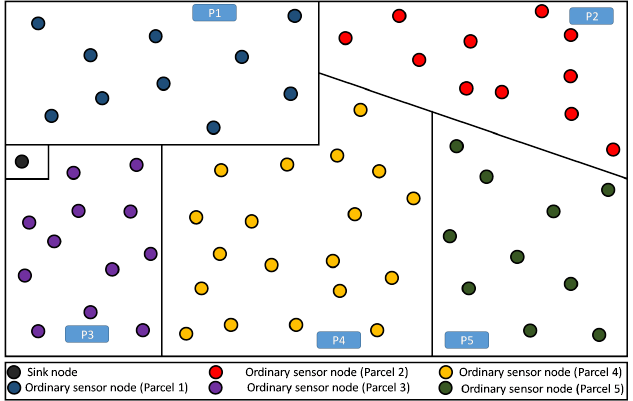
Figure 2. A farmland partitioning example: 5 parcels with randomly spread